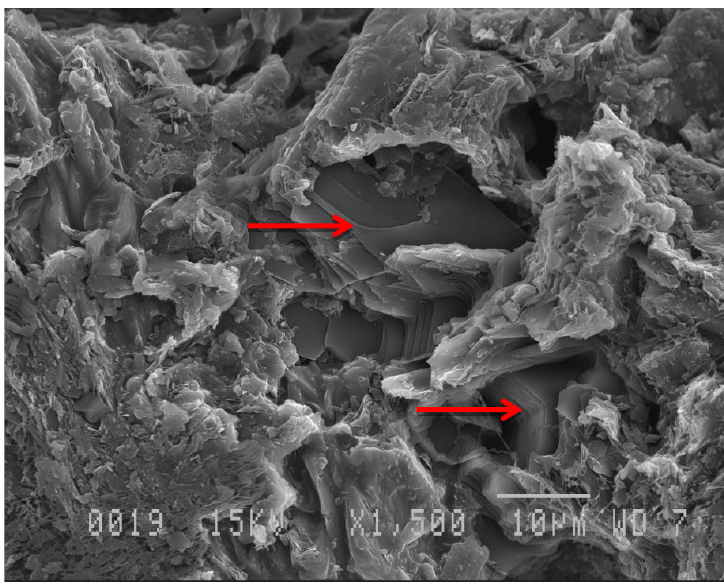
Figure 4. SEM micrograph of a sample cross-section showing the crystallization of boron oxide inside the pores (indicated by arrows).